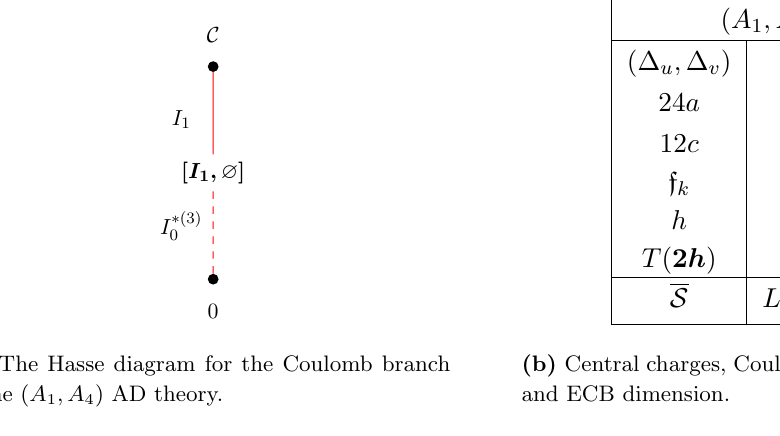
Figure 9. Information about the ( A 1 ; A 4 ) AD